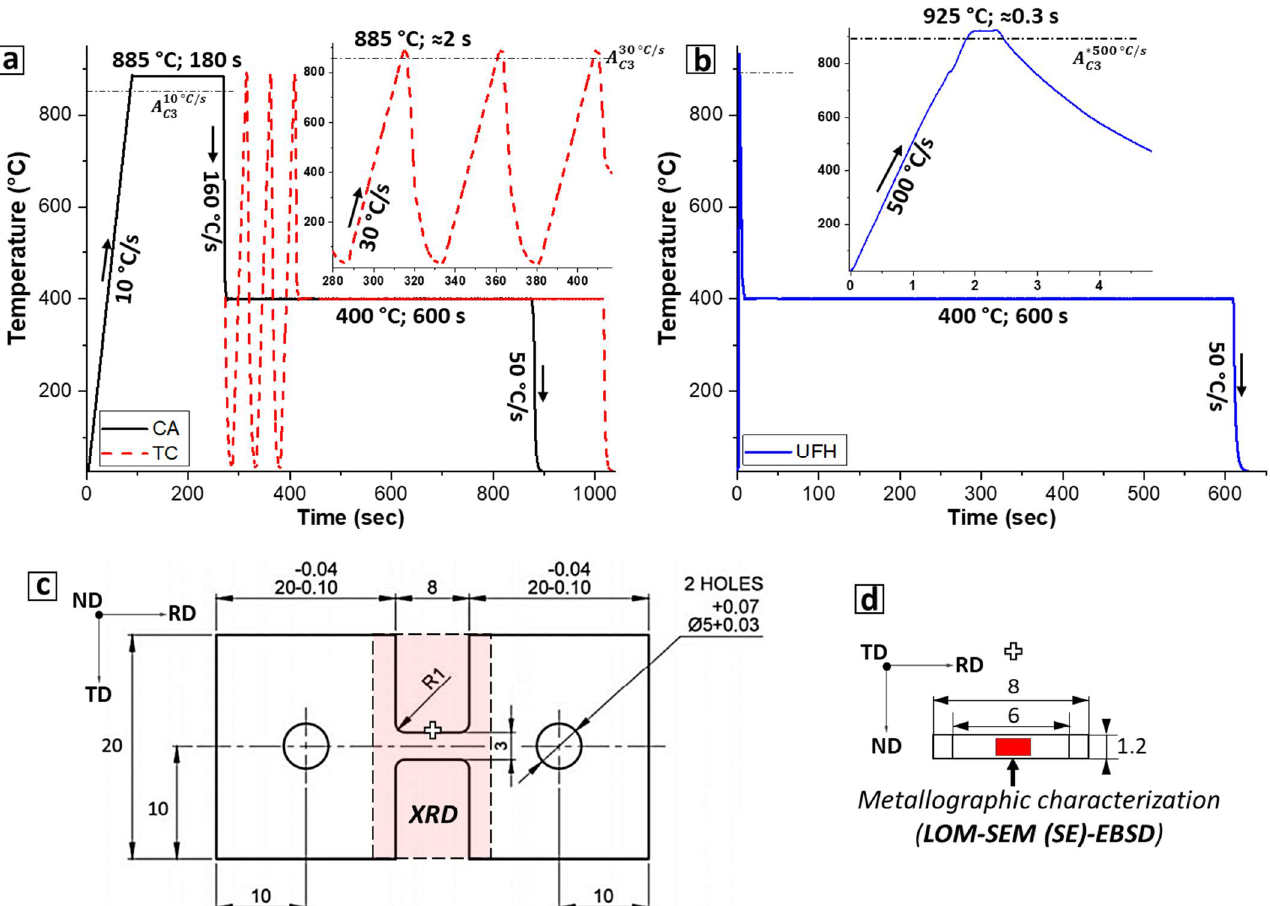
Figure 3. Record of the thermal treatments carried out in the Gleeble simulator: ( a ) CA and TC samples; ( b ) UFH sample. The inserts in ( a ) and ( b ) show the actual temperature recording for the TC and UFH samples, before the austempering step. Horizontal dotted lines denote the A C3 temperatures estimated by dilatometry. ( c ) Dog bone geometry and ( d ) area used microstructural characterizations (dimensions in mm). The area enclosed by dashed lines indicates the homogenously heat-treated zone obtained in samples treated using the Gleeble simulator. The cross next to the central region of the gauge length indicates the area used for metallographic characterization.